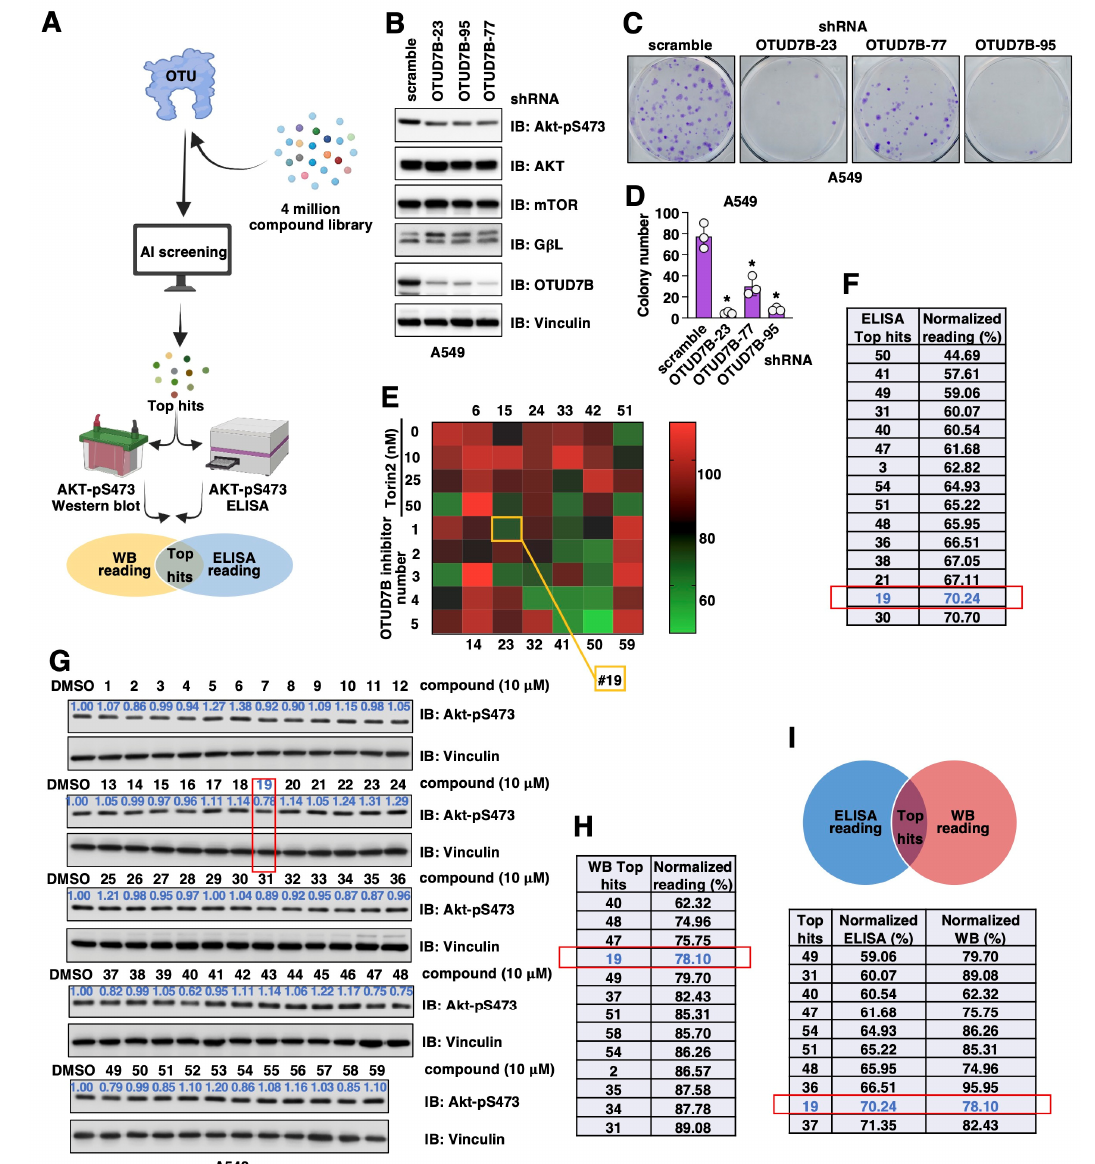
Figure 1. Searching for OTUD7B small molecule inhibitors. ( A ) A cartoon illustration for the pipeline of searching for OTUD7B small molecule inhibitors. AtomNet was used to search a 4 million small molecule library for hits fitting into the OTUD7B-OTU structure. Top hits were purchased and effects of OTUD7B inhibition by these small molecules were tested by both Akt-pS473 ELISA and Western blotting in A549 cells. Overlapping hits from two assays were identified and tested further. ( B ) Immunoblot (IB) analyses of whole cell lysates (WCL) derived from control or OTUD7B depleted A549 cells. ( C ) Representative colony formation analyses images using A549 cells obtained in ( B ) and quantified in ( D ). Error bars were calculated as mean+/-SD, n = 3. * p < 0.05 (one-way ANOVA test). ( E ) A heatmap illustration of Akt-pS473 ELISA results obtained from treating A549 cells with 10 µ M of each indicated chemical for 16 h. ( F ) A list of chemicals with the ability to suppress 30% Akt-pS473 signals from assays in ( E ). ( G ) IB analyses of WCL from A549 cells treated with indicated compounds for 16 h. ( H ) A list of chemicals with the ability to suppress 10% Akt-pS473 signals from assays in ( G ). ( I ) A list of overlapped hits from both ( F , H